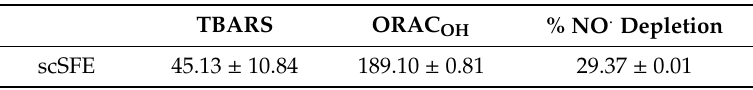
Table 5. Antioxidant capacity of scSFE. The results showed its activity against lipid peroxidation through a thiobarbituric acid reactive substances (TBARS) assay (% inhibition of lipid peroxidation of 5 mg / mL of extract), the hydroxyl radical capacity as determined by an ORAC OH assay (as µ mol quercetin eq. / g extract), and the capacity of the extract (200 µ g / mL) to deplete nitric oxide (% depletion). All the results are presented as the mean ±